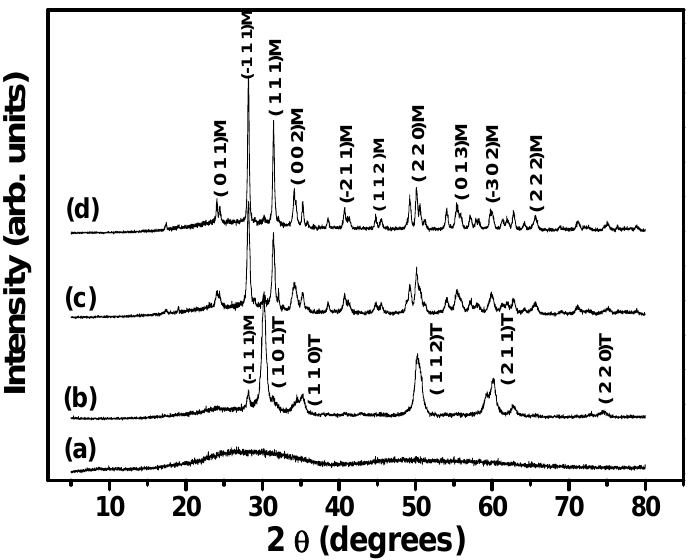
Figure 6. XRD patterns of zirconia foams fired at different temperatures: ( a ) 500 °C; ( b ) 600 °C; ( c ) 800 °C; ( d ) 1000